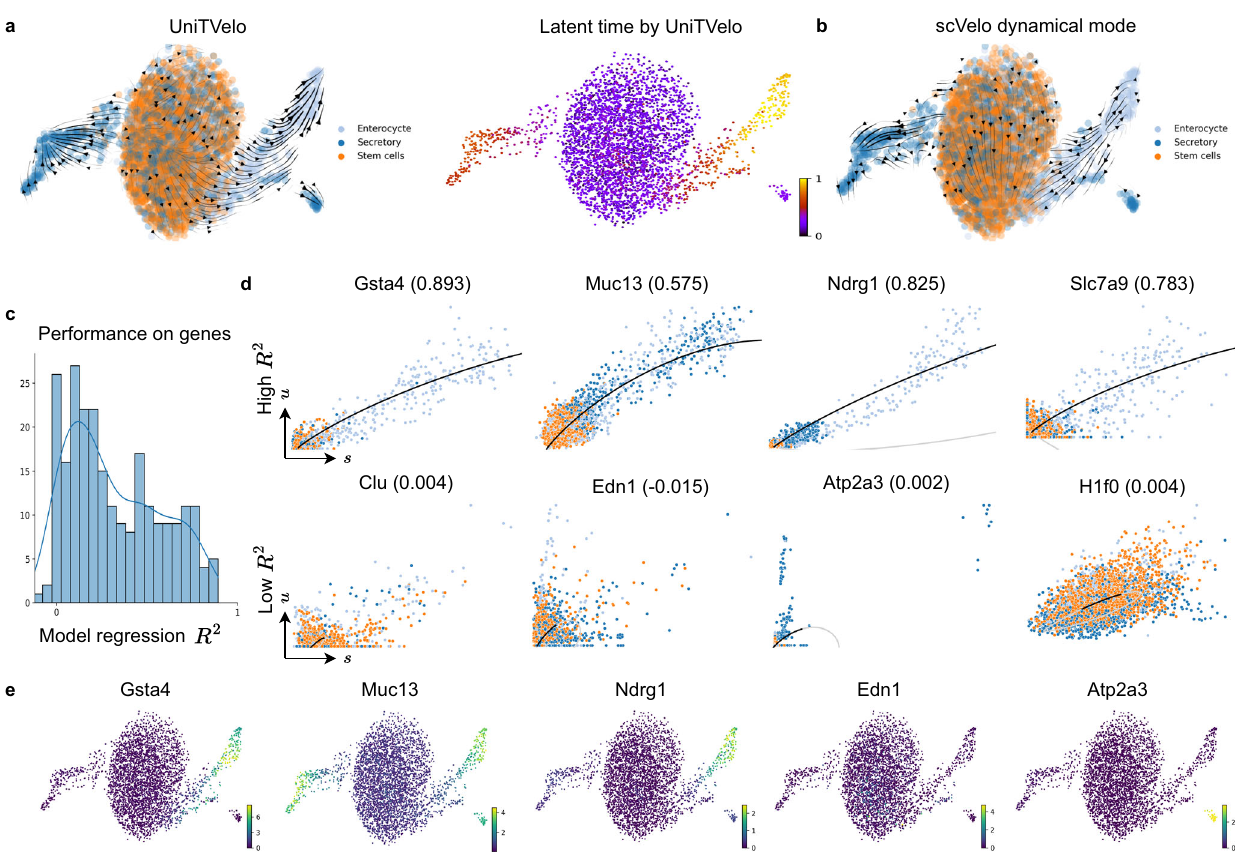
Fig. 4 | Delineating cell fate transitions in intestinal organoid. a Intestinal organoid differentiation dataset is acquired with scEU-seq. Without metabolic labeling knowledge, UniTVelo clearly reveals two differentiation branches to secretory and enterocyte lineage from stem cells in both velocity fi eld (left) and inferredlatenttime(right). b Onthecontrary,scVelorevealsadistortedorreversed directionality under same data inputs. c Histogram of the distribution of model